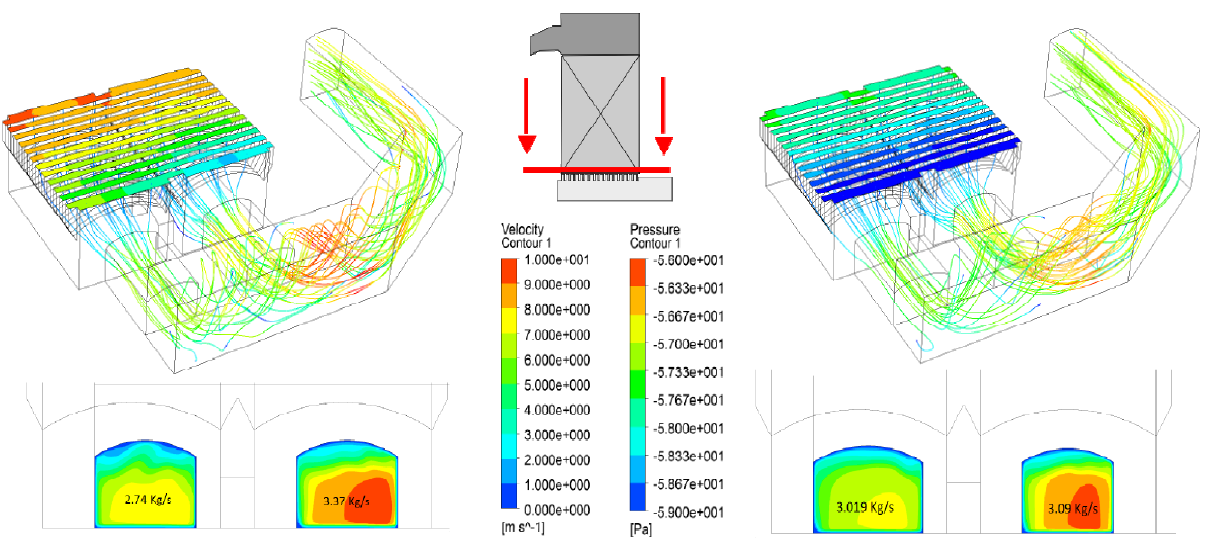
Figure 12. Duct original design and plant modification according to the proposed computational fluid dynamics (CFD)